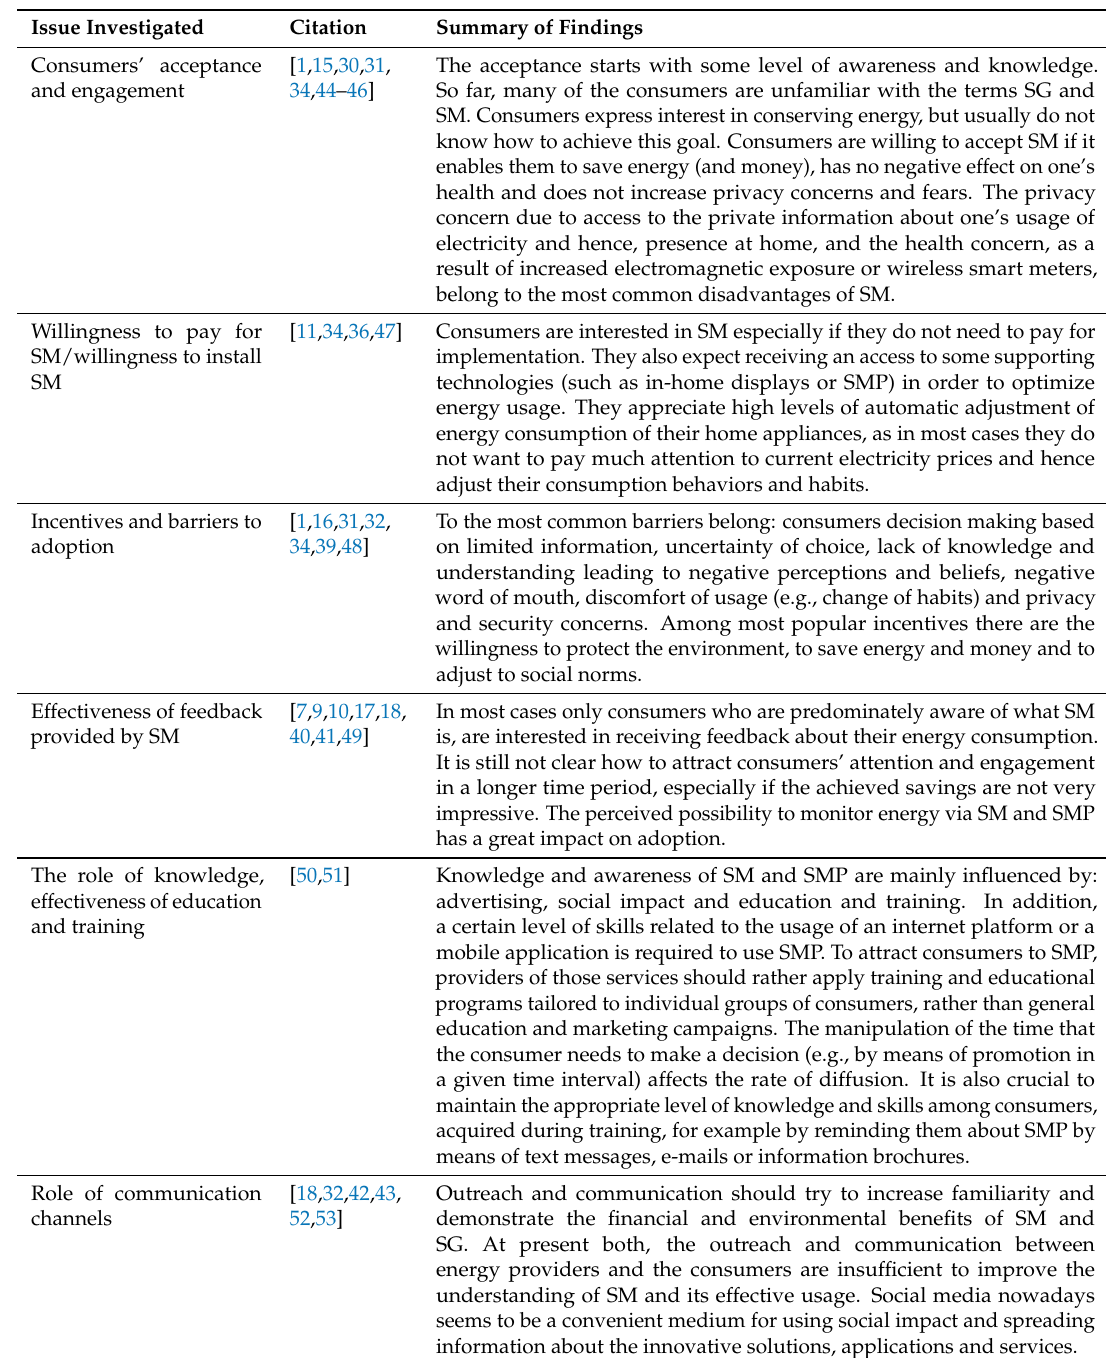
Table 1. Literature review: research aspects of the consumers’ acceptance and engagement towards smart meters (SM) and smart metering platforms